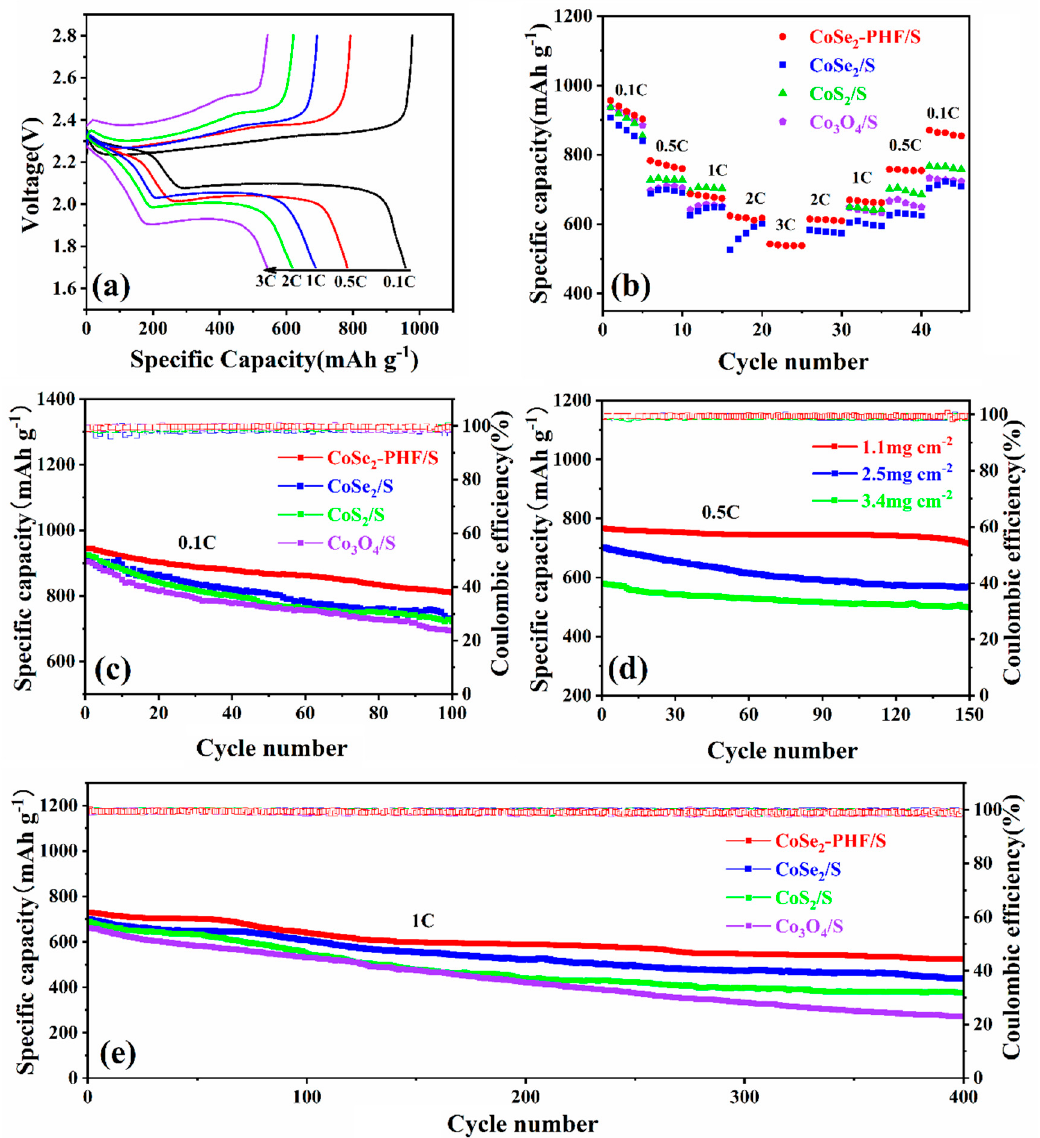
Figure 8. ( a ) Galvanostatic charge − discharge curves for CoSe 2 -PHF/S based electrodes at different current rates, ( b ) Rate performance of CoSe 2 -PHF/S, CoSe 2 /S, CoS 2 /S, and Co 3 O 4 /S based electrodes at various current rates, ( c ) Cycling performance of CoSe 2 -PHF/S, CoSe 2 /S, CoS 2 /S, and Co 3 O 4 /S based electrodes at 0.1 C with the sulfur loading of 1.3 mg cm − 1 , ( d ) Specific capacity of CoSe 2 -PHF/S with varied sulfur loadings at 0.5 C, ( e ) Cycling performance of CoSe 2 -PHF/S, CoSe 2 /S, CoS 2 /S, and Co 3 O 4 /S based electrodes at 1 C with the sulfur loading of 1.2 mg cm − 2